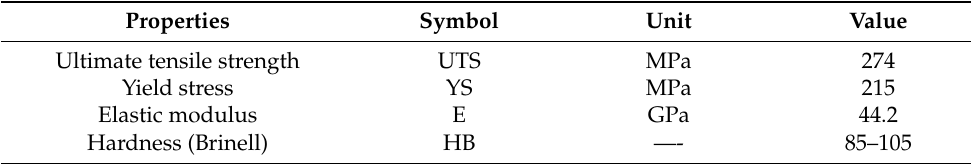
Table 14. Mechanical properties of WE43 magnesium alloy